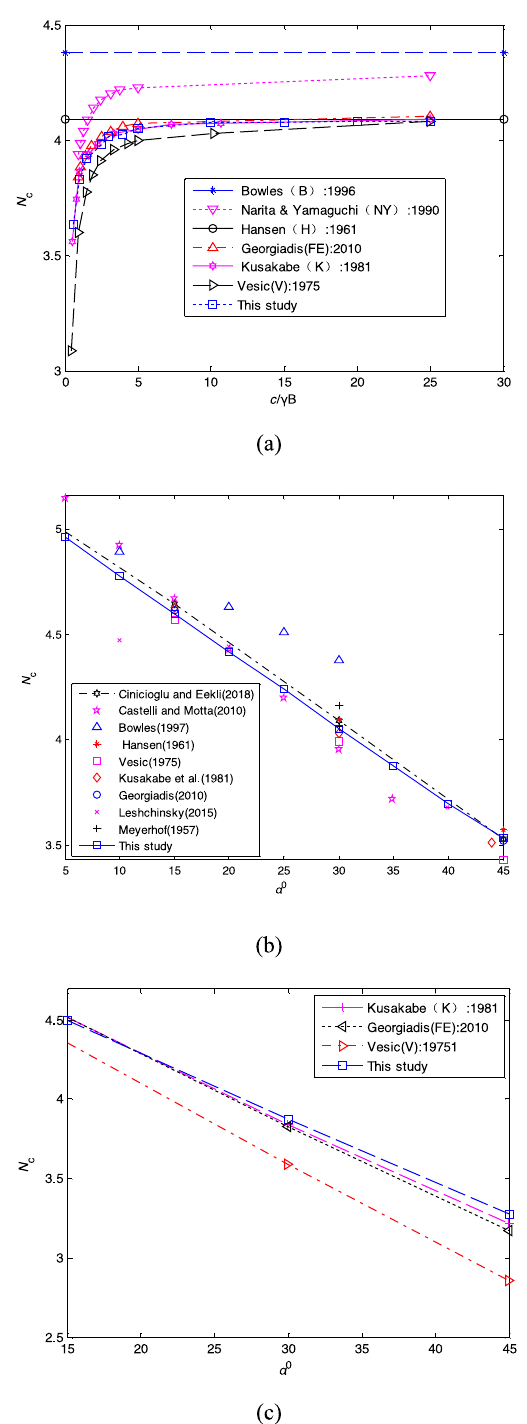
Figure 6. Variation of N c with c u /γB and α : ( a ) c/γB varying, α = 30°; ( b ) α varying, c/γB = 5; ( c ) α varying, c/ γB =